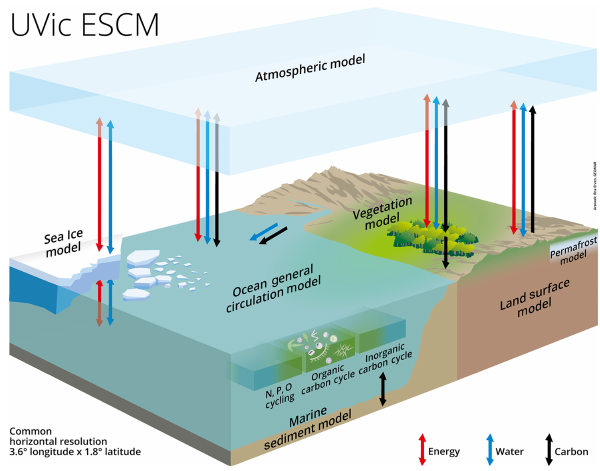
Figure 1. Schematic of the University of Victoria Earth System Cli- mate Model version 2.10 (UVic ESCM